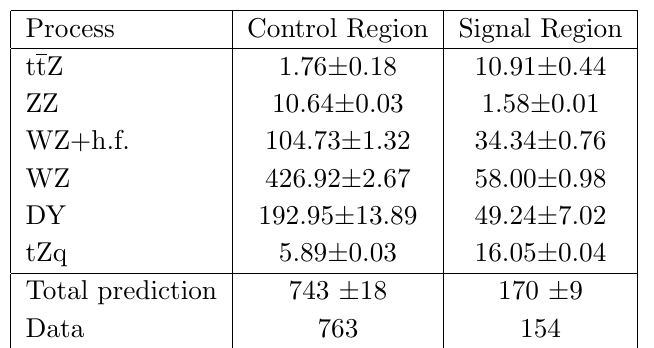
Table 1 . The event selections for the signal and control regions for the SM and FCNC analyses.